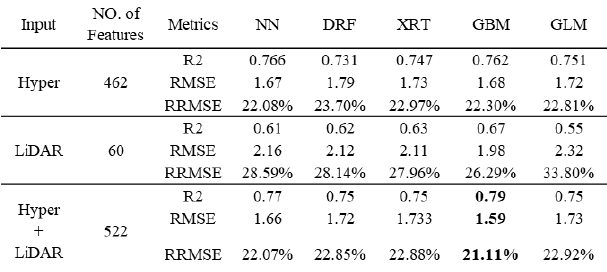
Table 2. Validation statistics of AutoML of maize yield